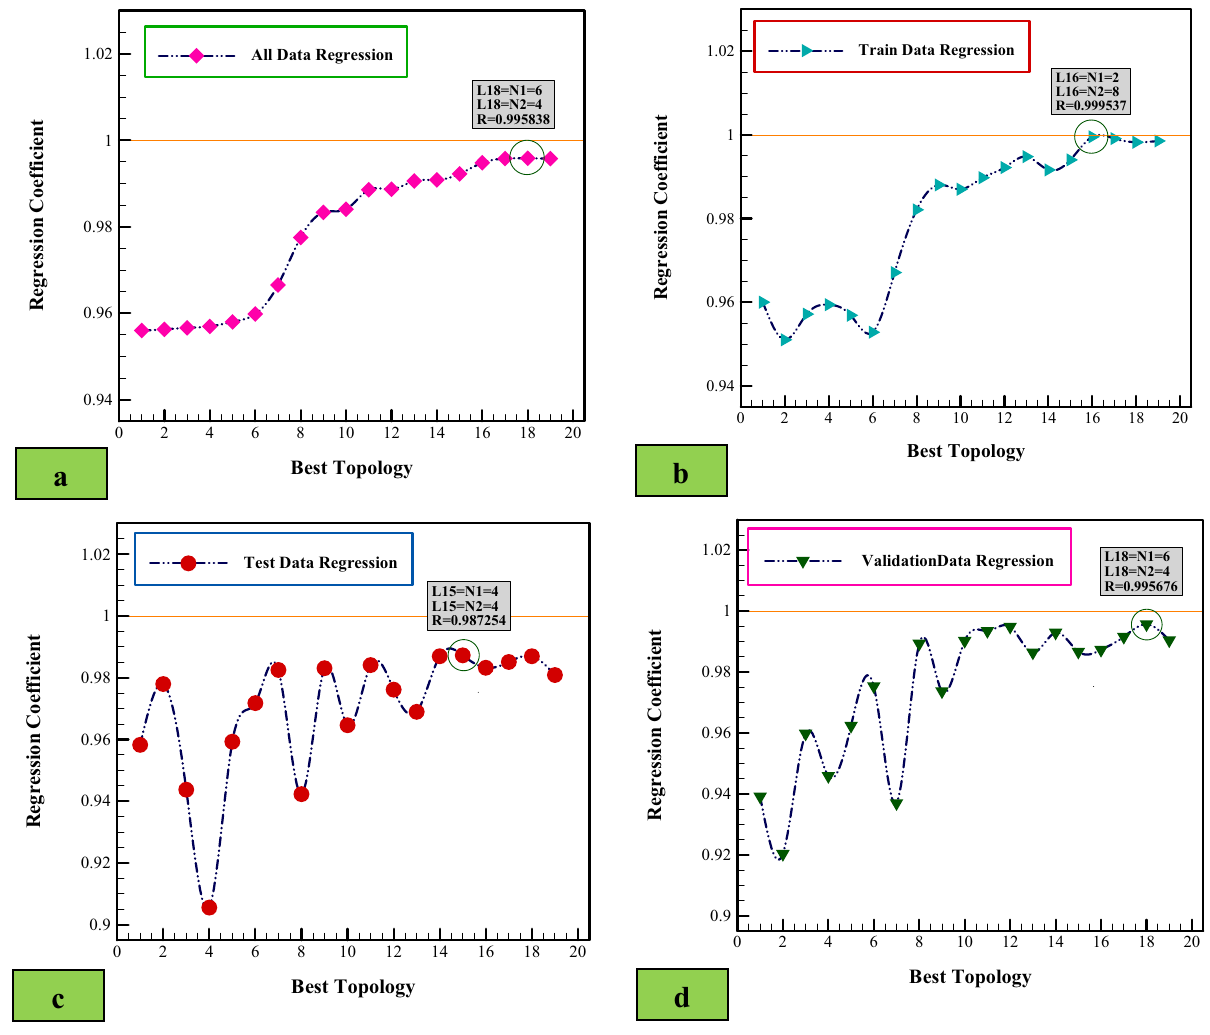
Figure 3. The regression as a function of hidden layer